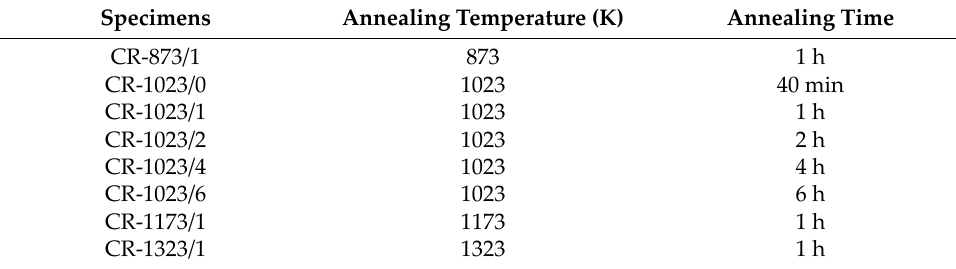
Figure 1. Details of fabrication process: ( a ) the schematic illustration of ingots; ( b ) the visualization of specimen extraction position. XRD = X-ray diffraction, SEM = scanning electron microscopy, EBSD = electron backscattered diffraction, TEM = transmission electron microscopy, RD = rolling direction, TD = transverse direction, and ND = normal direction. Table 1. Heat treatment conditions and sample designations.